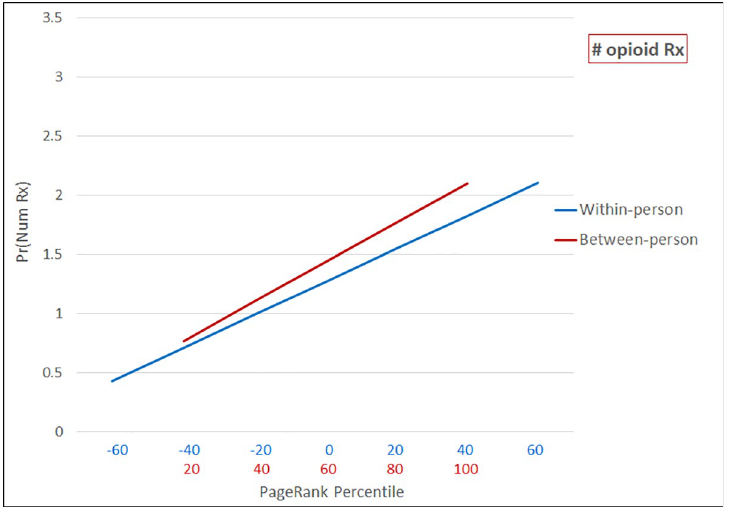
Fig 1. Predicted number of prescriptions as a function of within-person and between-person PageRank percentile (n = 526,914; n obs = 2,107,656).